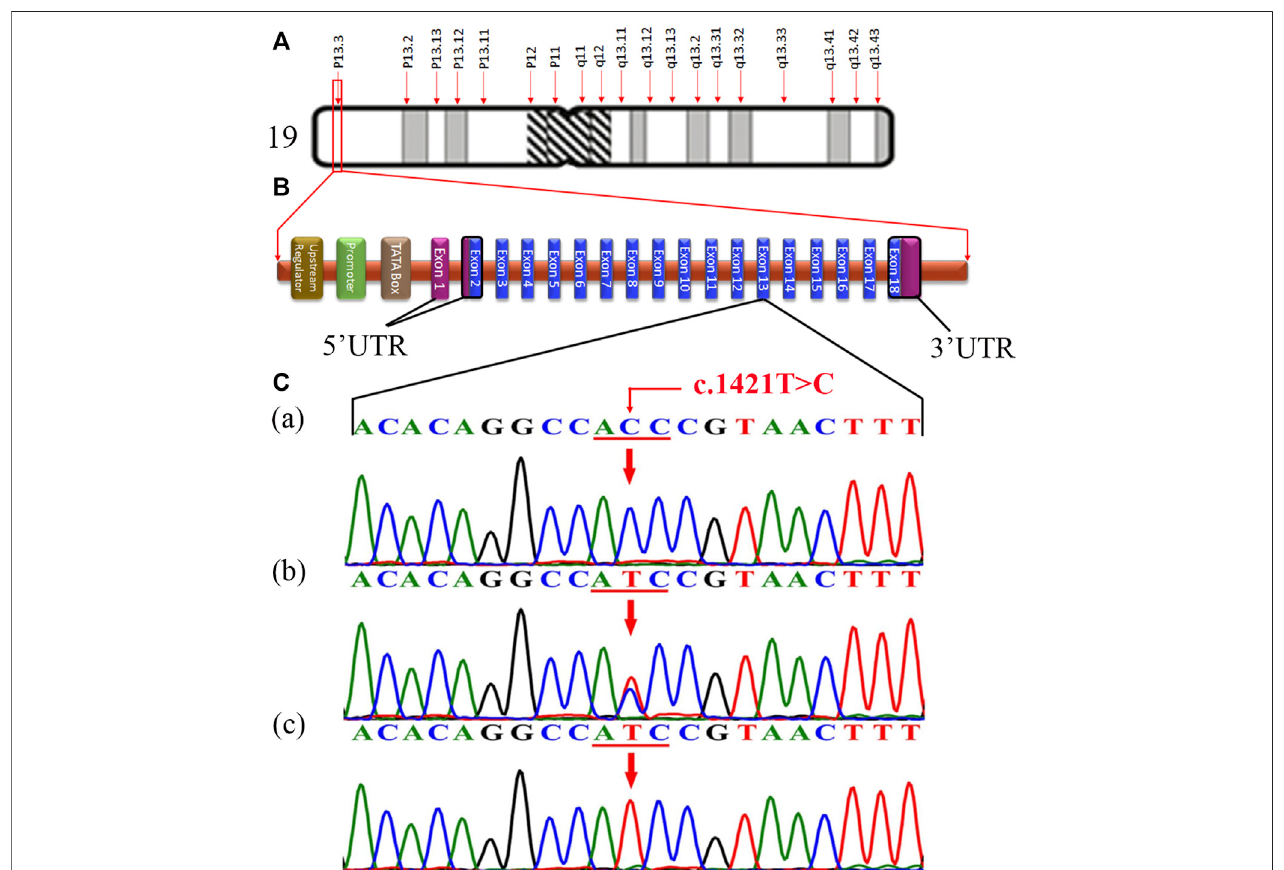
FIGURE 2 | (A) Structure of chromosome 19, showing the RFX2 locus (p13.3) (http://atlasgeneticsoncology.org/ISCN09/Chrom19ISCN09.html). (B) Typical structure of RFX2 containing 18 exons, showing the position of genetic alteration c.1421T > C in 13-exon in the present study (red) (generated manually using the information from ENSEMBL Genome Browser). (C) Chromatogram of an unaffected individual (IV-1) in the upper panel (a) , a carrier/heterozygous parent (III-1) in the middle panel (b) , and a homozygous affected individual (IV-4) in the lower panel (c)